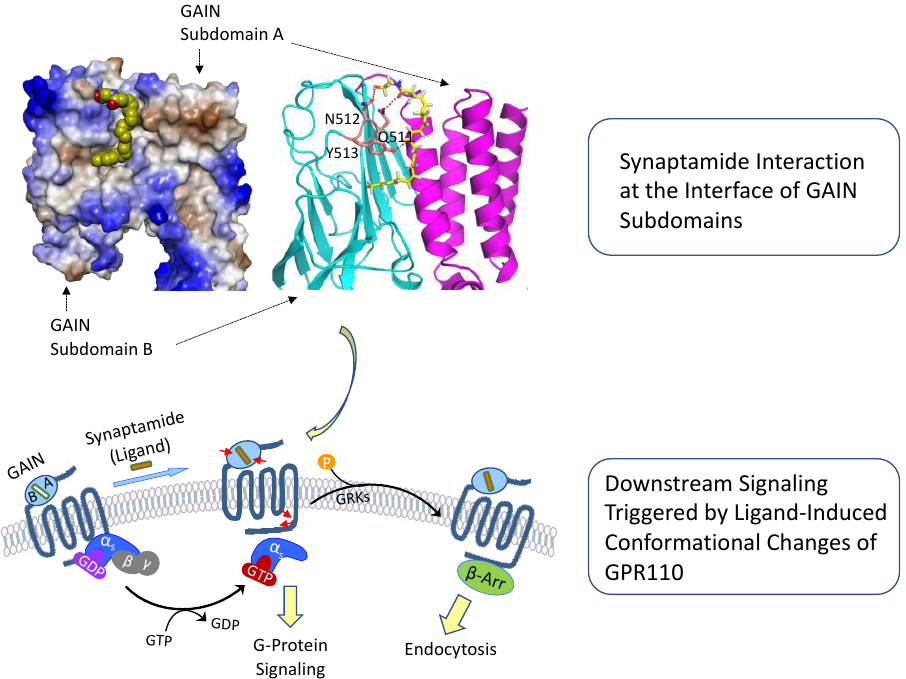
Figure 6. Activation of GPR110 and downstream signaling through synaptamide binding to the GAIN domain. Synaptamide is shown with a space-filling or stick-and-ball representation. Synaptamide binds to the interface between two subdomains, causing conformational changes in the GAIN and intracellular domains of GPR110 (depicted by red arrows) that trigger downstream signaling events. Adapted from reference [56]. GAIN, GPCR autoproteolysis domain; GTP, guanosine-5′-triphosphate; GDP, guanosine-5′-diphosphate.